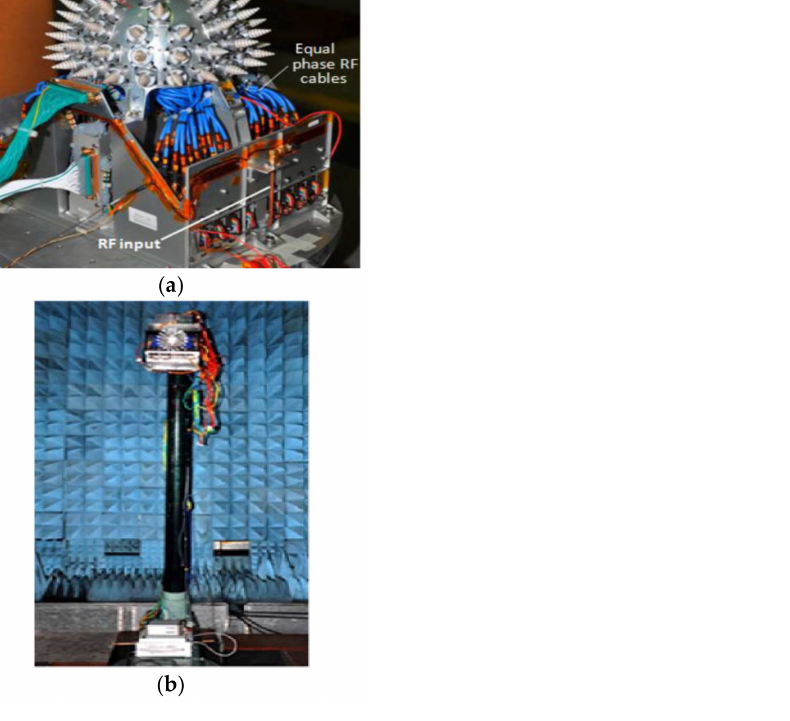
Figure 8. Experimental setup for measurement using an SAA. ( a ) SAA. ( b ) Configuration of the SPAA in anechoic chamber [8].